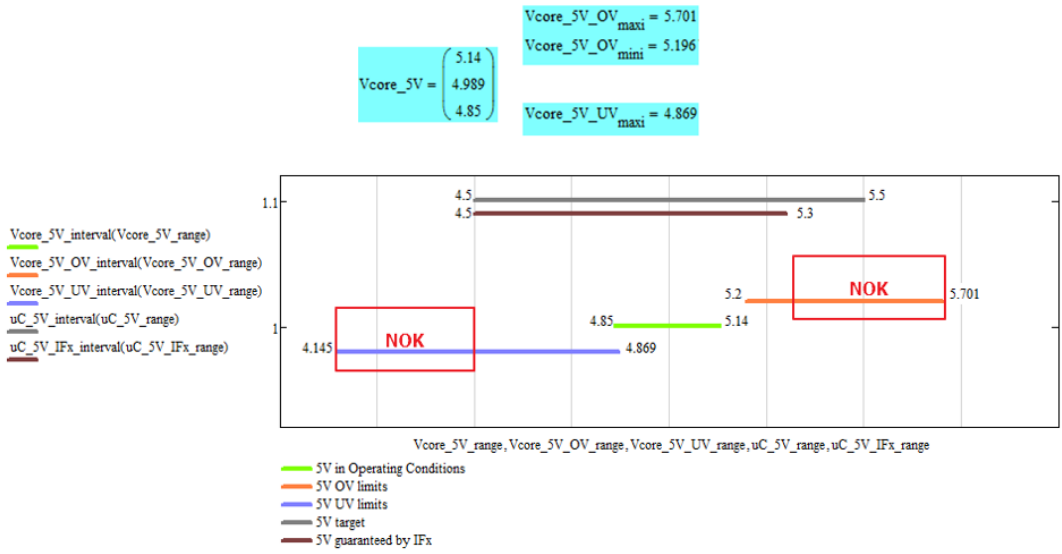
Figure 9. Mathcad plot overview of the detection range in a worst-case scenario.